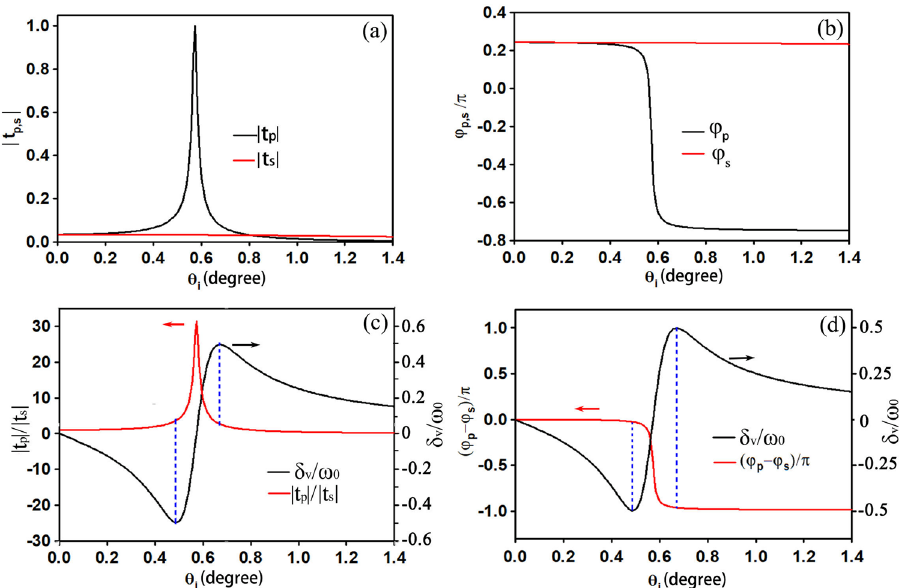
Figure 6. Amplitudes (a) and phase distributions (b) of the Fresnel transmission coefficients for the ENZ slab, (c) is the transverse shift and ratio of the Fresnel transmission coefficients near the Brewster angle, (d) is the transverse shift and phase difference distributions near the Brewster angle, where the thickness of the ENZ slab is 3λ, the refractive index is n = 0.01and the incident light is V-polarized Gaussian beam with a beam waist of